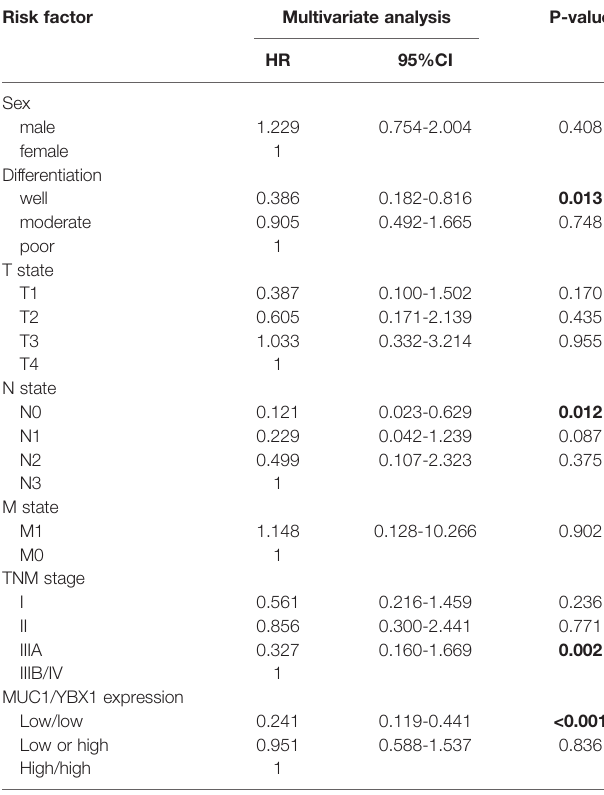
TABLE 4 | Multivariate analysis of overall survival using Cox regression. TABLE 3 | Univariate analysis of fi ve-year overall survival and disease-free